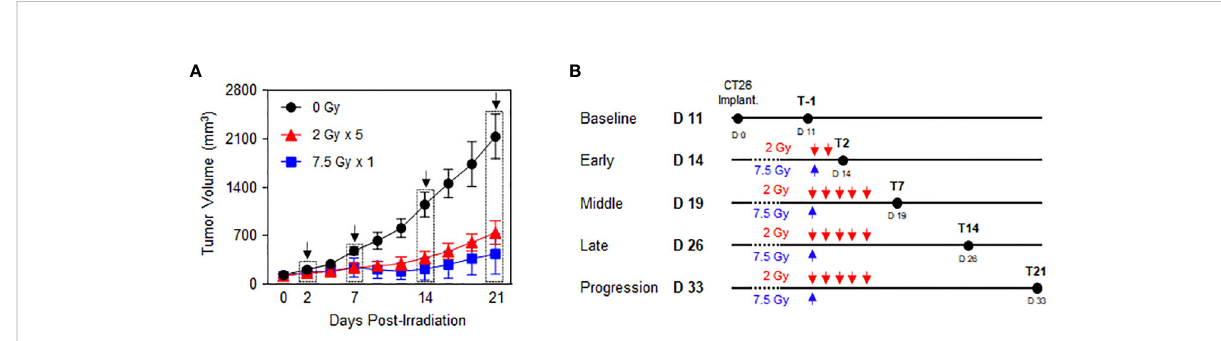
FIGURE 1 Time-course response phases following RT. CT26 cells were implanted in the right fl ank of six-week-old female BALB/c mice. After 12 d, the established tumors were locally irradiated with 2 Gy × 5 and 7.5 Gy × 1 (n = 3 – 4 mice per group). (A) Comparison of the tumor growth delay curves of mice irradiated with 0 Gy, 2 Gy × 5, and 7.5 Gy × 1: time points of the surgical evaluation are indicated by dotted rectangles with arrows. (B) Details of the radiation dose regimens and post-radiation time points of the surgical evaluation. These fi gures are based on the representative data obtained from at least two independent experiments. Abbreviation: RT,